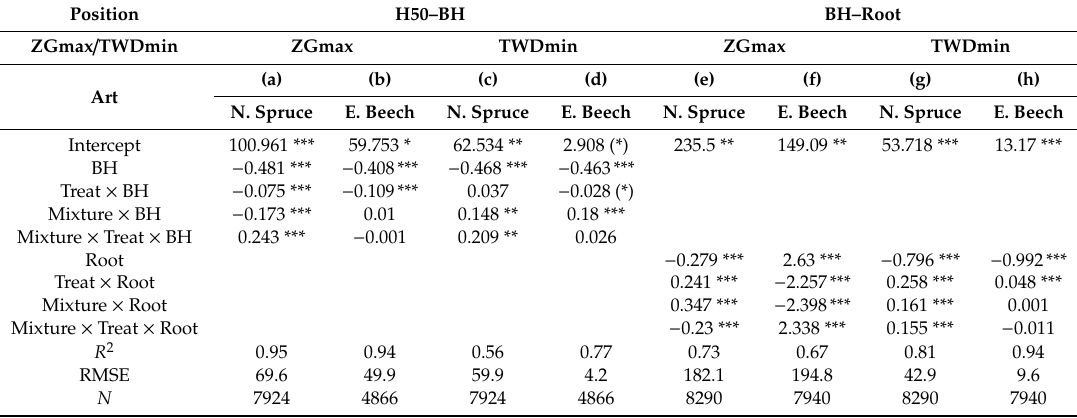
Table 3. Parameter estimates and statistics for the diameter growth (ZGmax) and tree water deficit (TWDmin) of the 50% tree height (H50) and stem at breast height (BH) from Figure 5 and stem at breast height (BH) and root from Figure 6, dependent on drought (treat) and species mixing (mixture). The dependent variables are in the columns. Rows show the output of the model with the fixed variables ( N : number of measurements). Significance levels: *** p < 0.001; ** p < 0.01; * p < 0.05; (*) p <